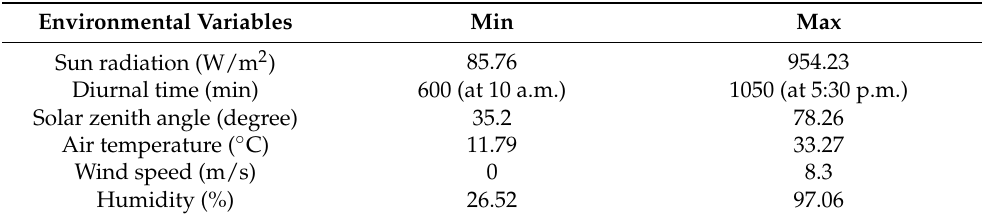
Figure 4. Single-factor correlation analysis for NDVI. The x-axis is the environment factors and their squared or root squared formats. The y-axis is the adjusted R2 between each x variable and the calculated environment-induced variation in NDVI. Larger adjusted R2 value means the variable is more correlated to the NDVI variation. Table 4. The ranges in environmental conditions experienced by the modeling data during the experiment.